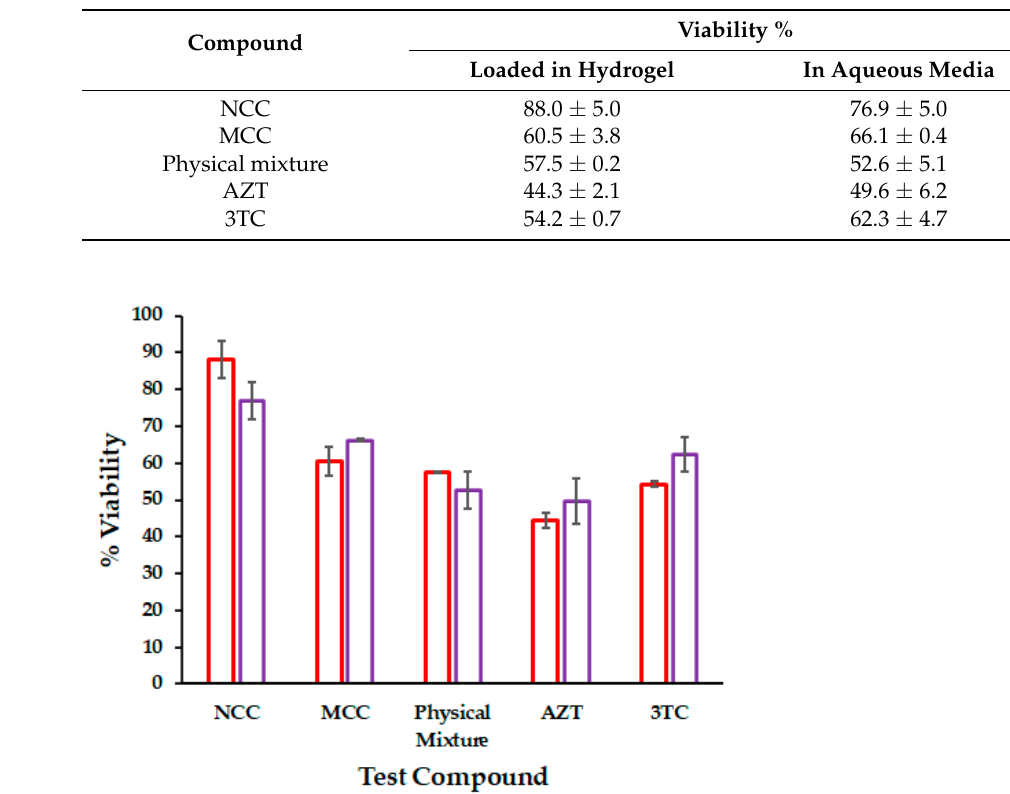
Table 8. Summary of cytotoxicity results.